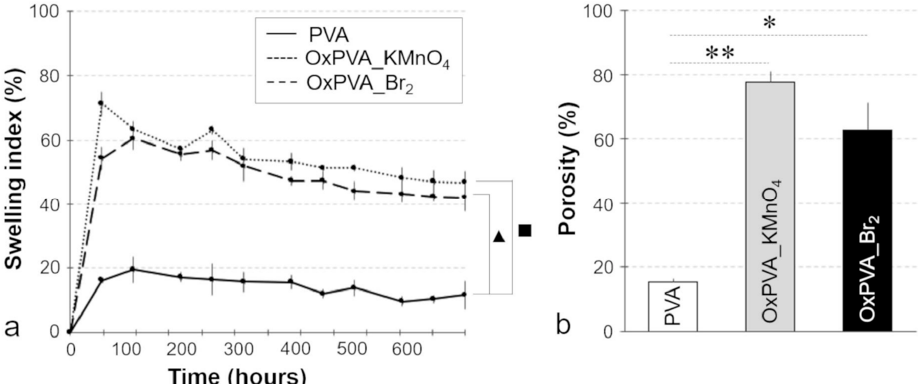
Figure 1. Swelling behavior and porosity of PVA-based hydrogels. Effect of chemical oxidation on PVA swelling kinetics ( a ) and porosity ( b ). The experiments were repeated on three samples of each hydrogel at all time points. Response is the average swelling/porosity of replicates ± standard deviation. ( ■ : p < 0.05, OxPVA_KMnO 4 vs. PVA; ▲ : p < 0.05, OxPVA_Br 2 vs. PVA; **: p < 0.01, OxPVA_KMnO 4 vs. PVA; *: p < 0.05, OxPVA_Br 2 vs. PVA).